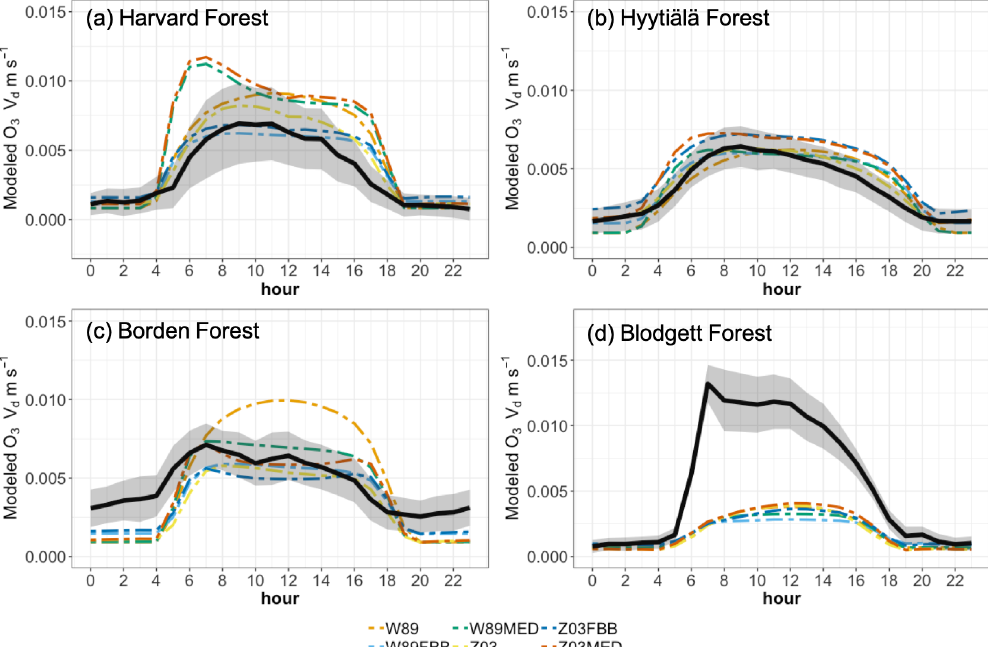
Figure 3. Average diurnal cycles of ozone dry deposition velocity at four long-term observational sites. Black solid lines indicate observed average diurnal cycles of v d . Shaded envelope indicates standard deviation of summertime average hourly v d . Dashed lines indicate simulated diurnal cycles of v d using different dry deposition schemes.